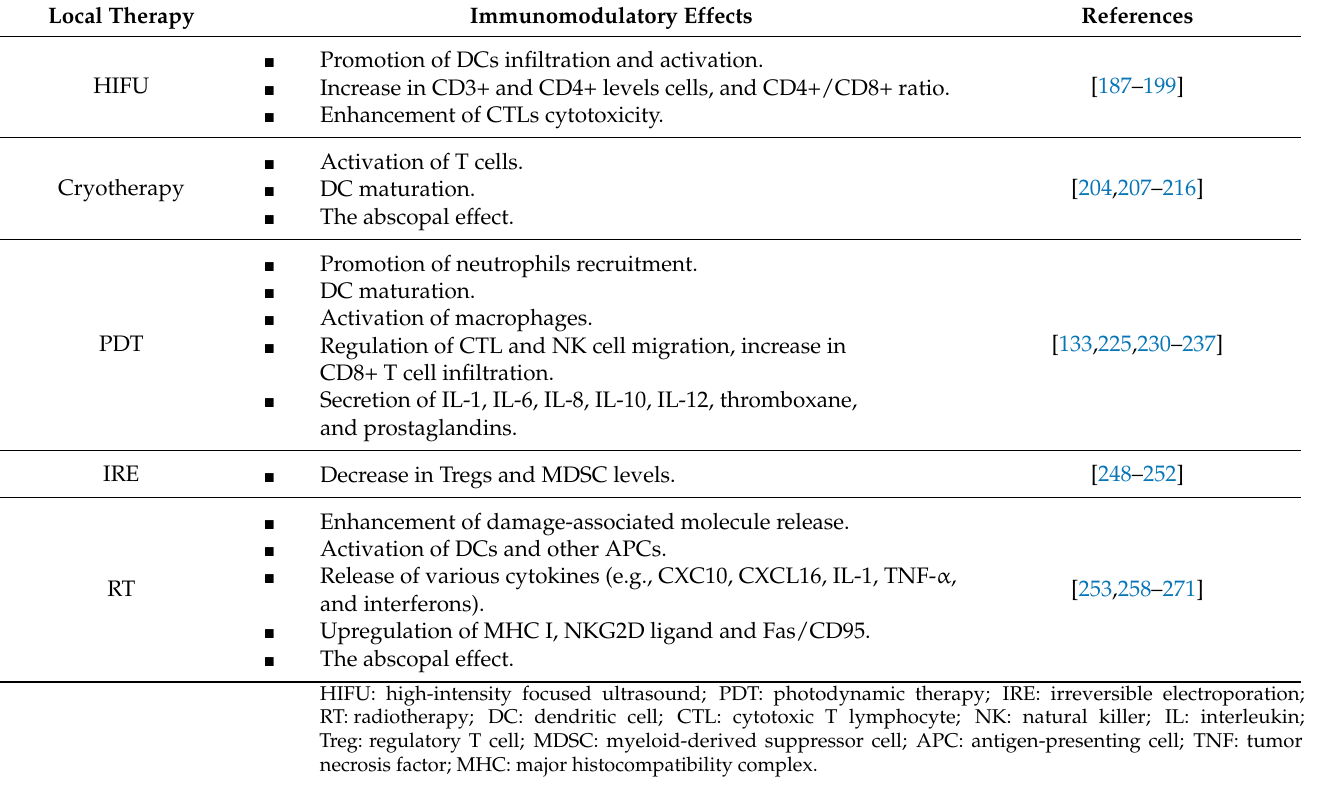
Table 2. Immunomodulatory impact of local treatment strategies on the TME. Local